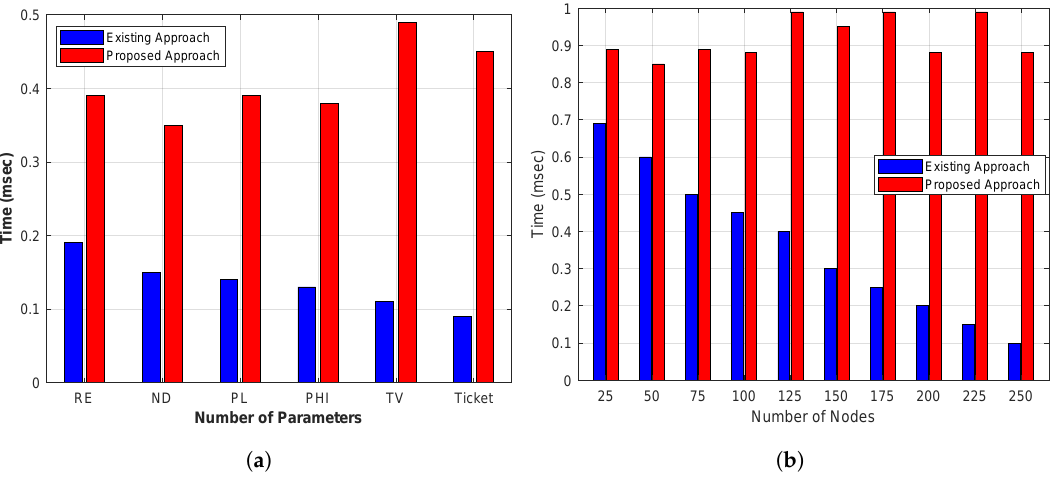
Figure 8. ( a ) Relative trust evaluated by both approaches. ( b ) Trust evaluated by the nodes on different network sizes where the malicious nodes are increasing at 10 percent in every network size.